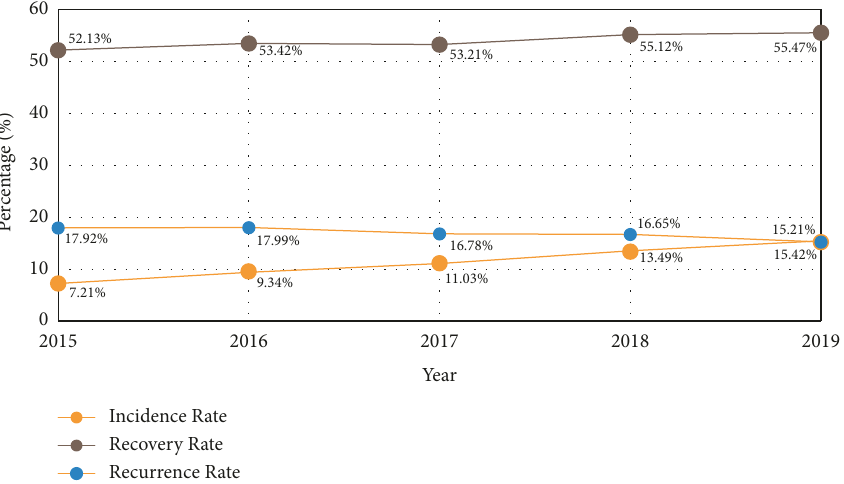
Figure 2: Statistical data of the incidence and treatment of the knee joint.